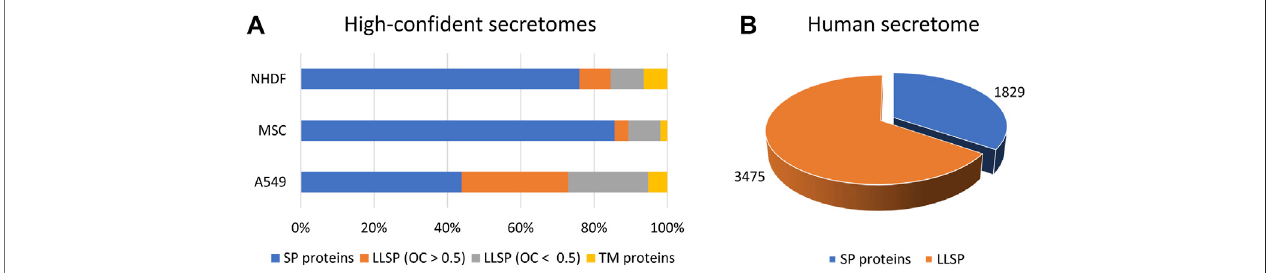
FIGURE 1 | High-con fi dent secretomes and the human secretome. (A) By means of comparative secretomics approach we were able to generate lists of high- con fi dent secreted proteins of NHDF, MSC and A549 cells including 72 – 88% of proteins which were predicted to be secreted (Poschmann et al., 2021). (B) Our prediction tool OutCyte was used to estimate the number of candidates LLSP in the human secretome to 3,475 (Zhao et al., 2019). LLSP: leaderless secreted proteins. SP proteins: signal peptide containing proteins. OC: OutCyte score. TM proteins: transmembrane proteins.